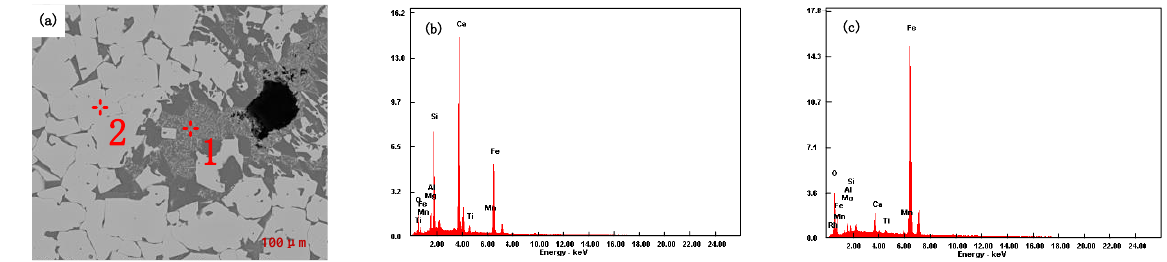
Figure 13. Scheme 1 SEM and EDS diagram of sinter: ( a ) Scheme 1 sinter, ( b ) 1, ( c ) 2.